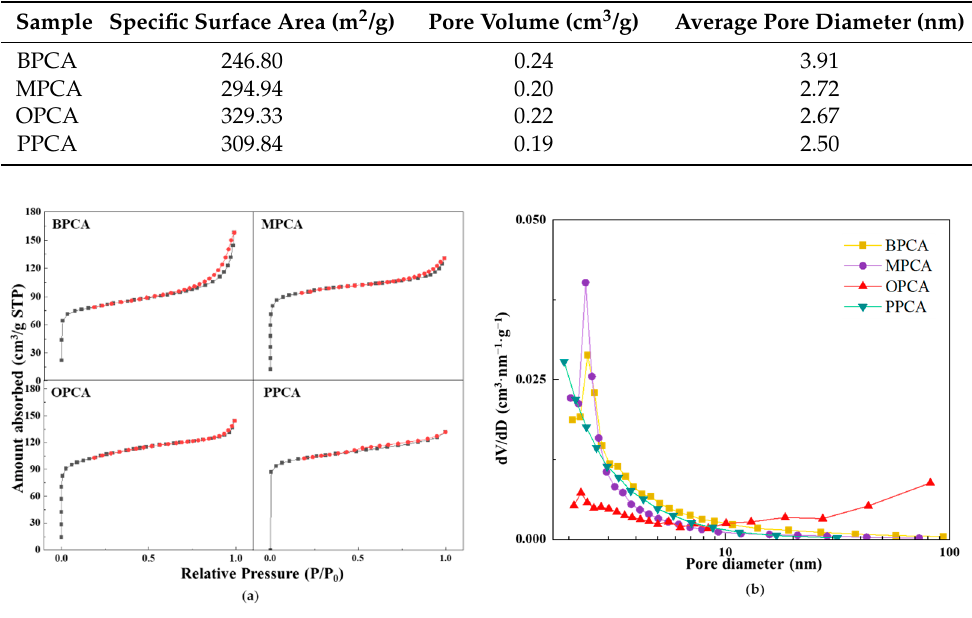
Figure 6. Isotherm curves ( a ) and pore size distribution curves ( b ) of CAs prepared from different waste biomasses.